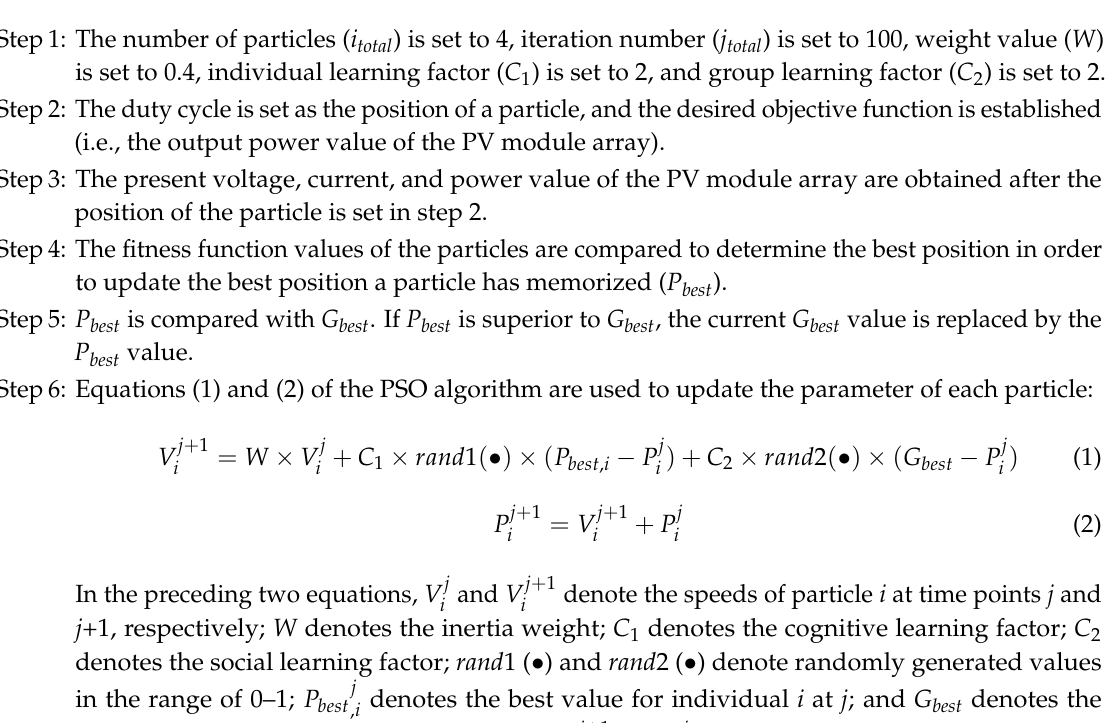
Figure 1. Schematic of PSO search approach.